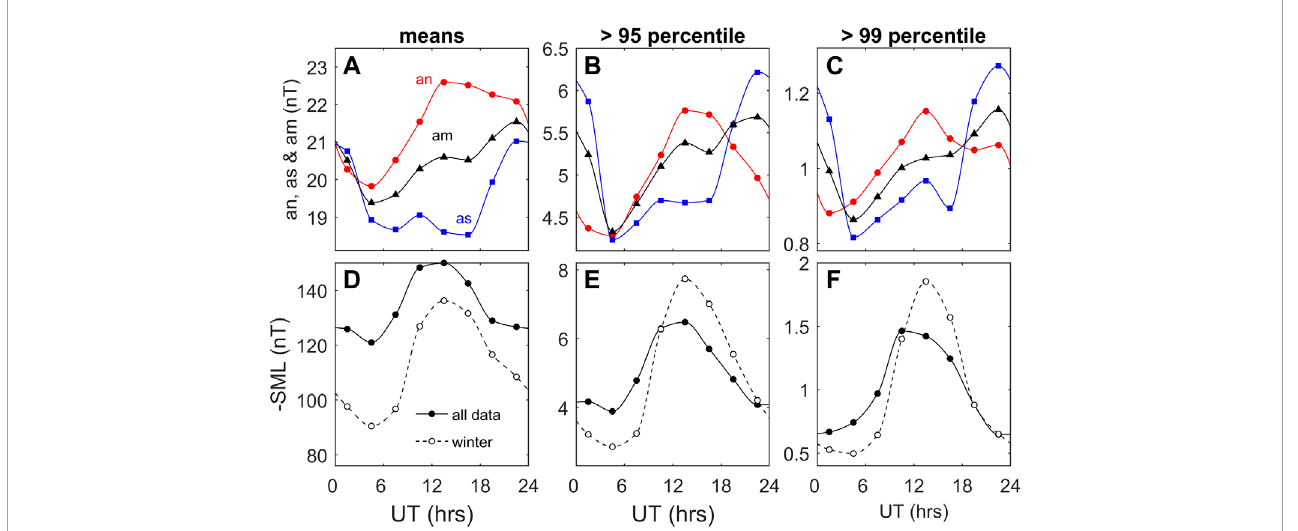
FIGURE 8 UT variations in (left column) mean values (middle column) the percentage of data exceeding the 95th-percentile; and (right column) the percentage of data exceeding the 99th-percentile for geomagnetic indices. The top row is for the mid-latitude am indices (Mayaud, 1980): the black line with black triangle symbols is for am , the red line with red circle symbols is for its northern hemisphere sub-index, an and the blue line with blue square symbols is for its southern hemisphere sub-index, as . The lower panel is for -SML , where SML is the SuperMAG auroral electrojet index, equivalent to AL and compiled from a large number (typically 100) of northern hemisphere stations (Newell and Gjerloev, 2011a; Newell and Gjerloev, 2011b). The solid line with filled circles is for all data and the dashed line with open circle symbols is for data taken within 15 days of the winter solstice. The am , an and as data are for 1959–2021, inclusive, and the SML data are 1976–2021,